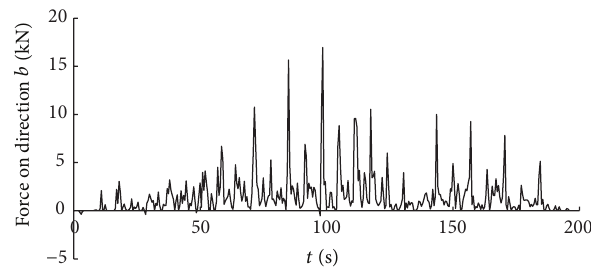
Figure 12: Time history curve of the force on direction 𝑏 on cutting head.